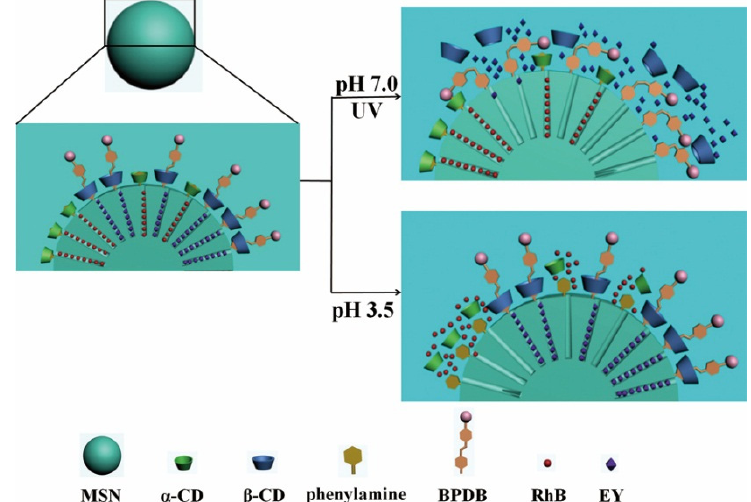
Figure 10. The release process of the dual-dye-loaded MSNs. The dual dyes were loaded into the MSNs separately by pH-controlled nanogates and UV-controlled nanovalves. This system can selectively release Eosin Yellowish (EY) upon UV irradiation (at pH 7.0)